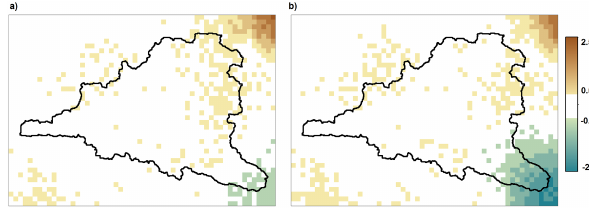
Figure 6. Differences in equilibrium DTWT between ParFlow.CLM simulations after re-initializations and ParFlow.CLM after 20years of baseline spin-up simulations in meters, where (a) is based on hydrostatic pressure head distribution above the water table for the initial condition, while (b) is based on adjusted pressure head distribution above the water table for the Skjern River sub-catchment. White regions correspond to grid cells where the differences in equilibrium DTWT are less than 0.5.